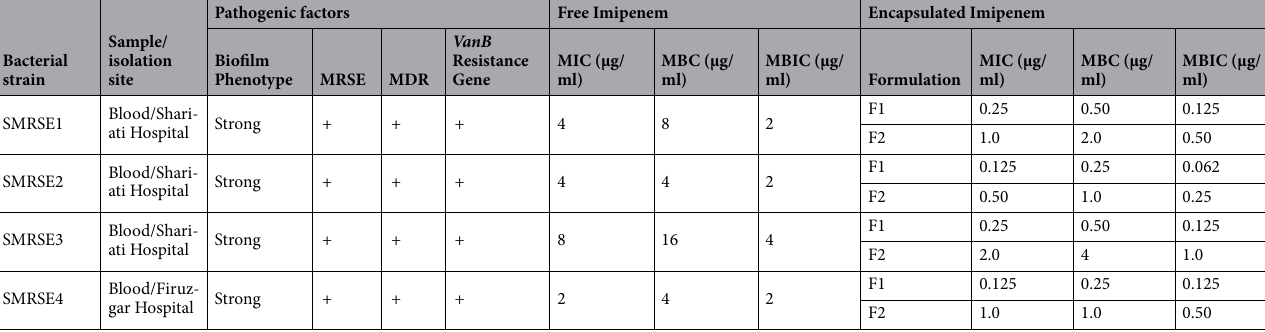
Table 5. Values of MIC, MBC, and MBIC in various Niosome-encapsulated imipenem formulations and free imipenem against resistant S. epidermidis